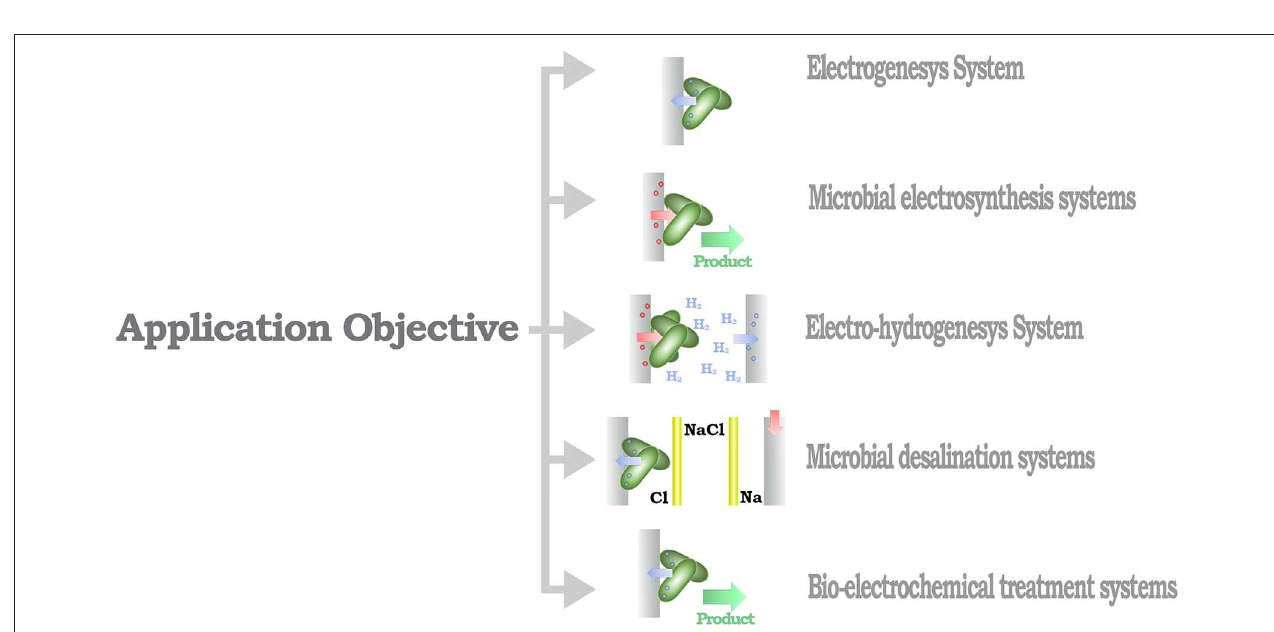
FIGURE 4 | Schematic organization of the MES classification based in the application objective and exemplary diagrams for each application.